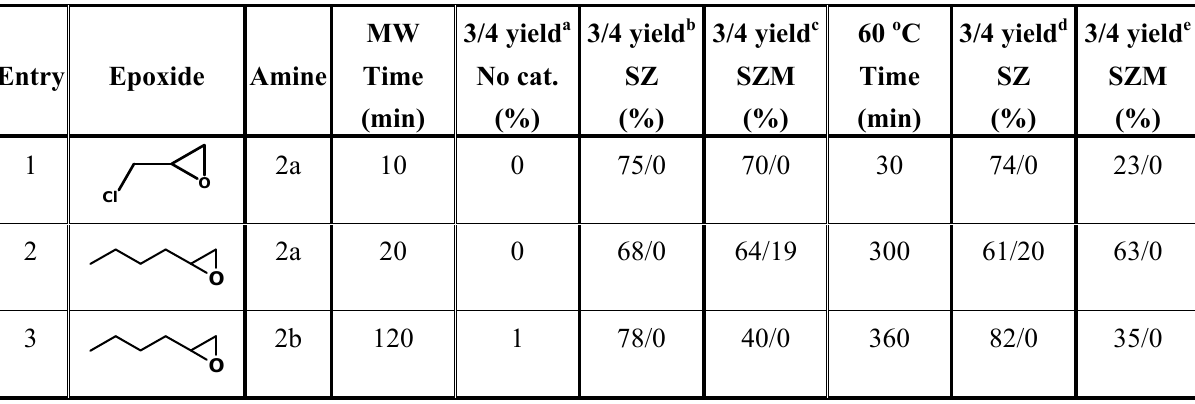
Table 2. Yields (%) (3/4 refers to Scheme 1), calculated using GC-FID and compared with published data